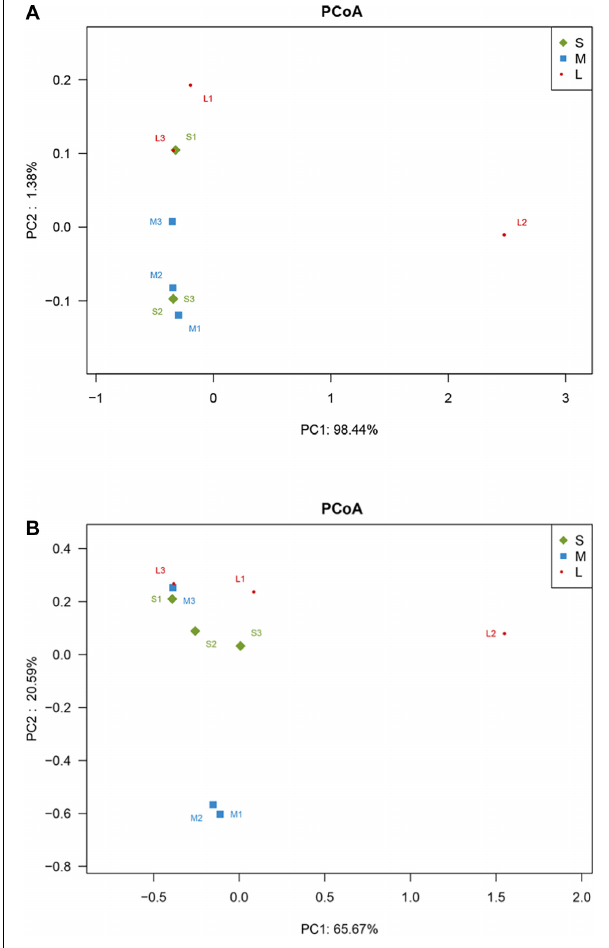
FIGURE 3 | PCoA plot of Bray-Curtis distances between samples. (A) Eukaryotic composition of the yellowfin sea bream stomach contents. (B) Microbiome of the yellowfin sea bream stomach